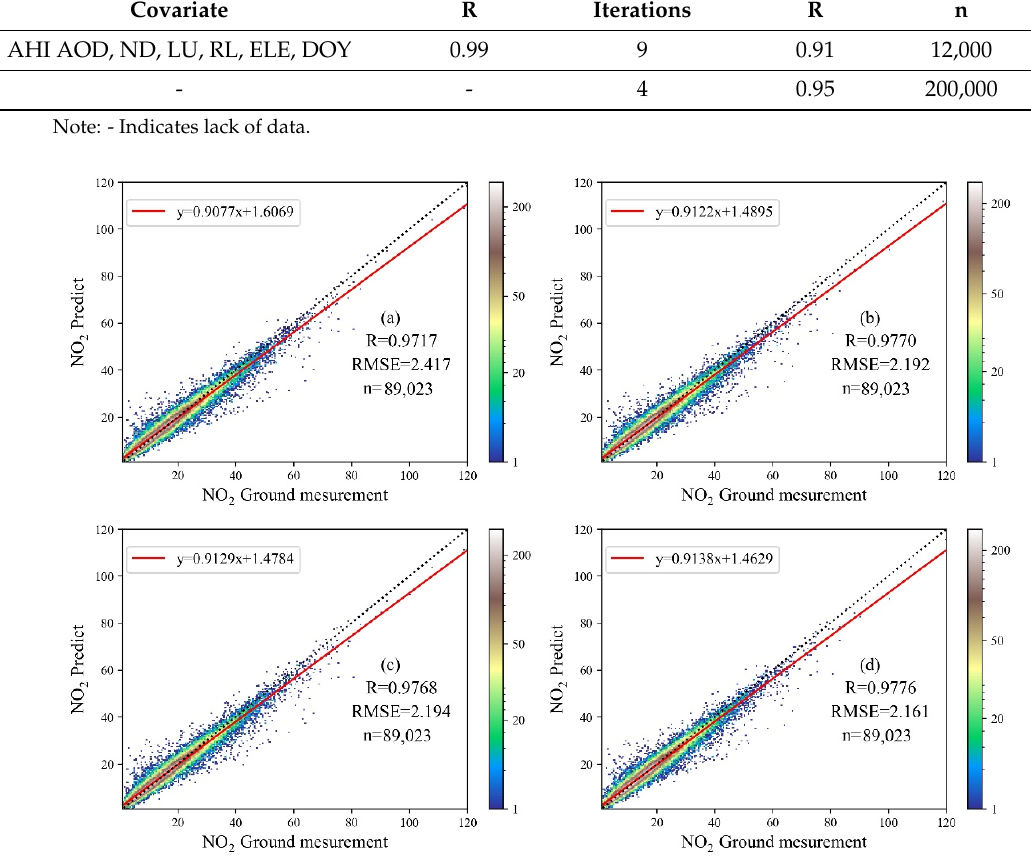
Figure 3. CV diagram of the training dataset. ( a ) RF model CV, ( b ) RF–RID model CV, ( c ) RF–CID model CV, and ( d ) RF–Ps CV. The dashed line represents the 1:1 ratio line, the solid red line represents the first-order linear fitting function curve, and the color bar represents the point density.